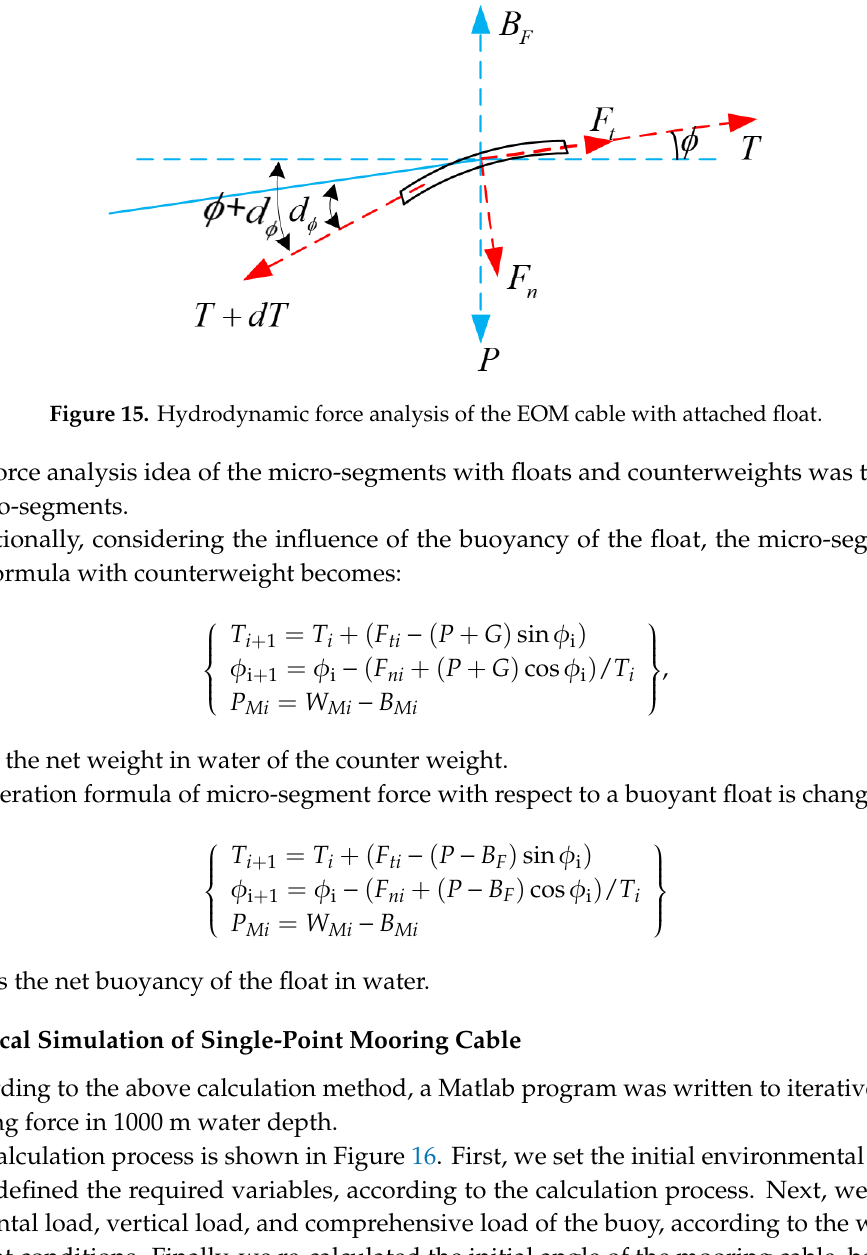
Figure 14. Hydrodynamic force analysis of the EOM cable with attached ballast.